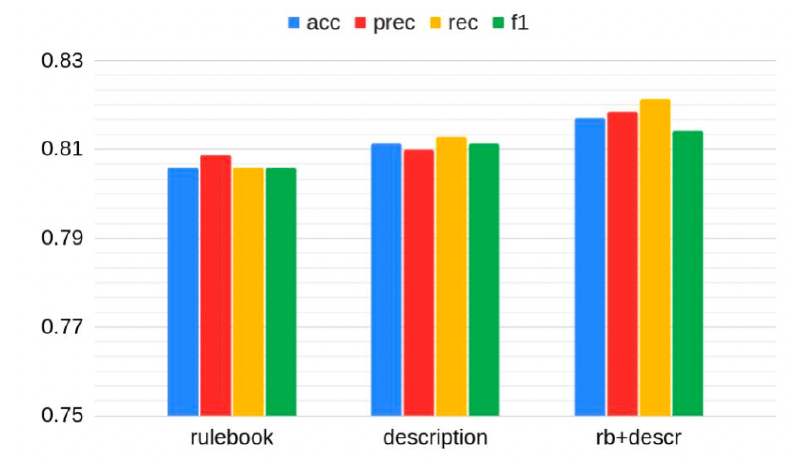
Figure 5. Obtained accuracy results for game category classification.